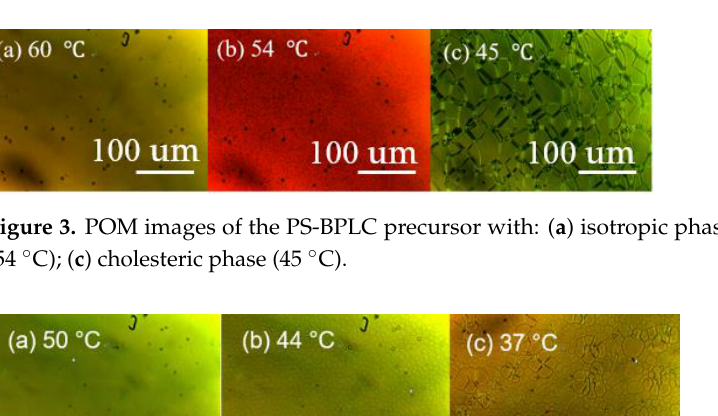
Figure 2. POM images of the PS-CLC precursor with: ( a ) isotropic phase (65 °C ) ; ( b ) cholesteric phase (30 °C ) .